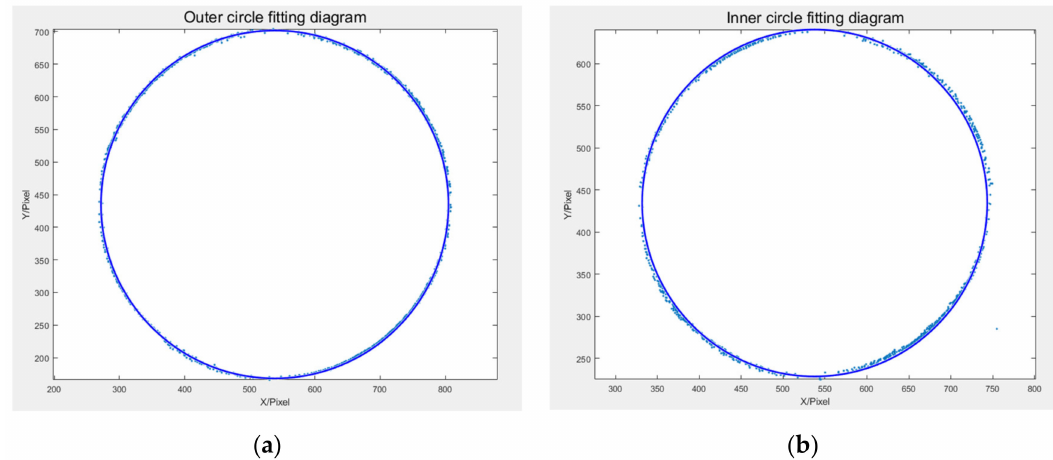
Figure 9. O-ring inner and outer circle fitting diagram. ( a ) Fitting of the O-ring outer diameter circle; ( b ) fitting of inner diameter circle of the O-ring.